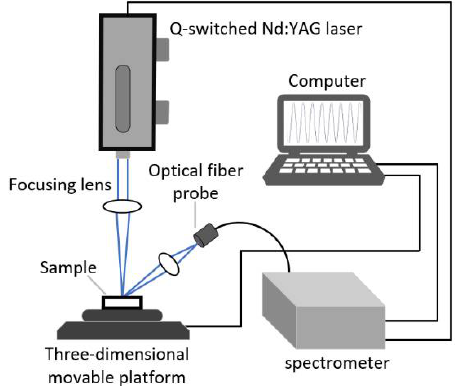
Figure 2. Plot of the LIBS experimental platform.